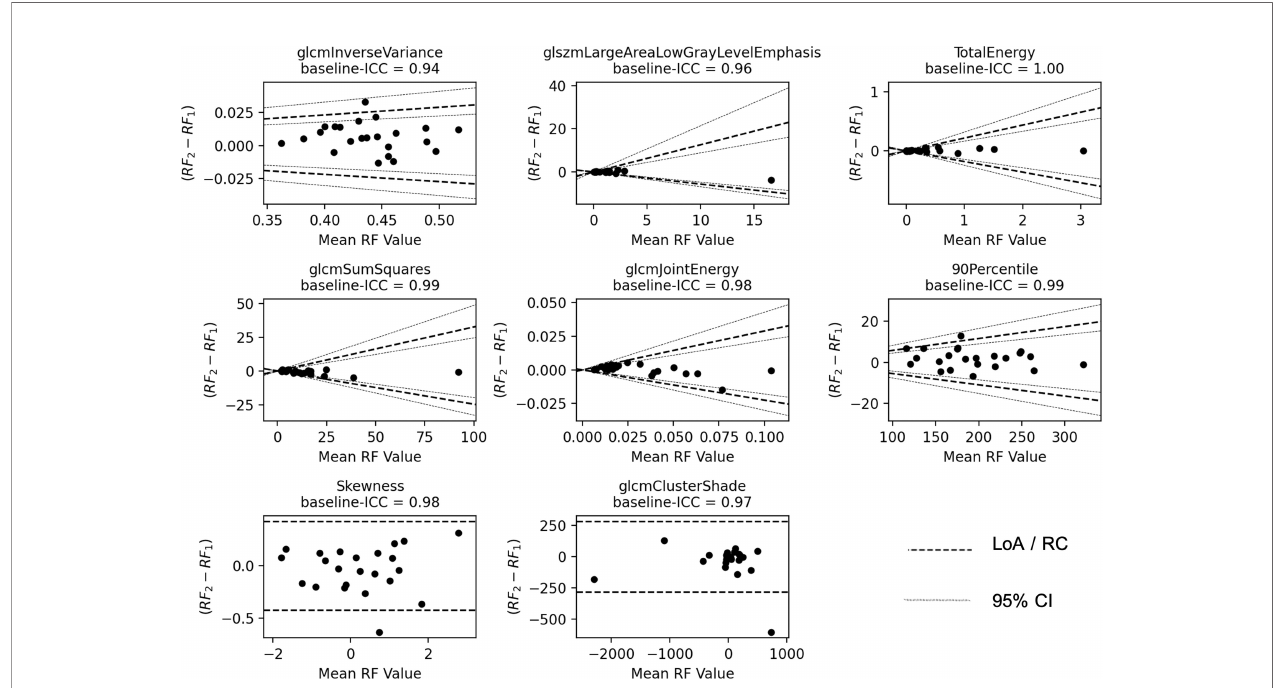
FIGURE 3 | Bland – Altman plots. The vertical axis shows the difference between the two radiomic feature (RF) values and the horizontal axis shows the mean value. The LoA and their 95% con fi dence intervals (CI) are shown as dashed and dotted lines, respectively. For Skewness and glcmClusterShade, the repeatability coef fi cient (RC) is shown